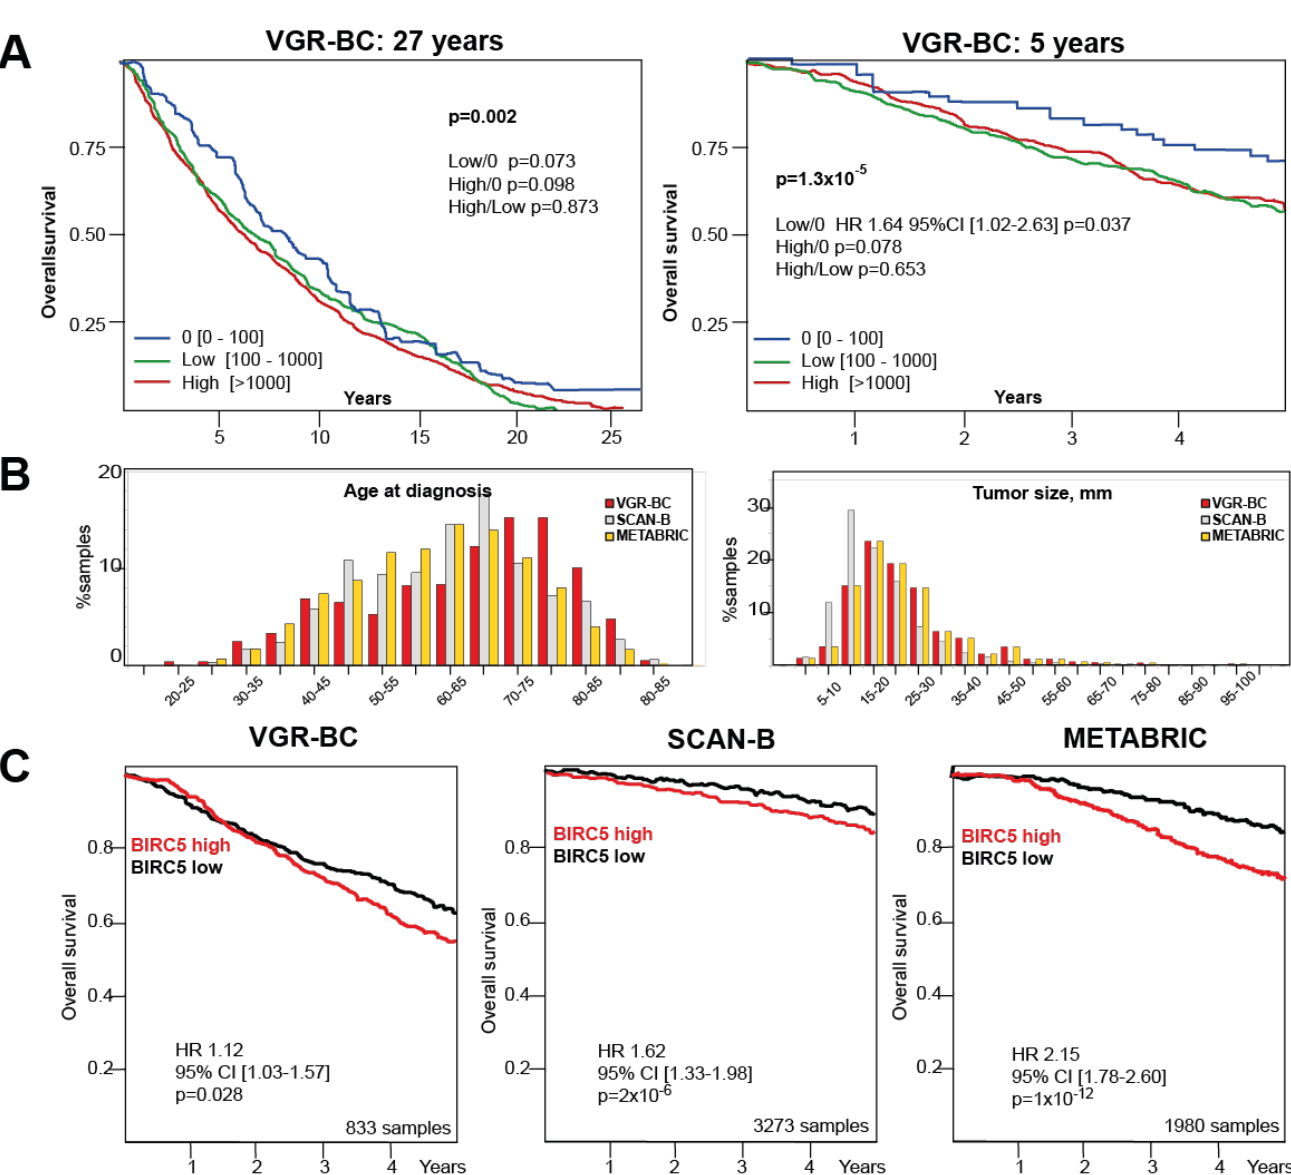
Figure 1. BIRC5/survivin levels contribute to survival probability in three independent breast cancer cohorts of different data and clinical characteristics. ( A ) Kaplan-Meier curves depict 27 and 5 years of overall survival for the VGR-BC cohort, split by the BIRC5/survivin levels into “0”, below the threshold ( n = 66); “Low” (100–1000 pg/1 g total protein, n = 536) and ”High” ( >1000 pg/1 g total protein, n = 234) BIRC5/survivin levels. Mantel-Cox log rank test was used for pairwise comparisons. ( B ) Comparative analysis of VGR-BC, SCAN-B, and METABRIC cohorts. Histograms present the age distributions at diagnosis and tumor size within VGR-BC, SCAN-B, and METABRIC cohorts. Percent of total samples size was independently calculated for each cohort. ( C ) Kaplan-Meier curves depict 5-year overall survival probability for patients of the VGR-BC, SCAN-B, and METABRIC cohorts. Survival curves shown for total datasets, split to the BIRC5/survivin median level was done based on the protein levels in the tumor lysates in the VGR-BC, and mRNA levels in SCAN-B and METABRIC. Hazard ratio was estimated separately for the high- and low-level patient groups.